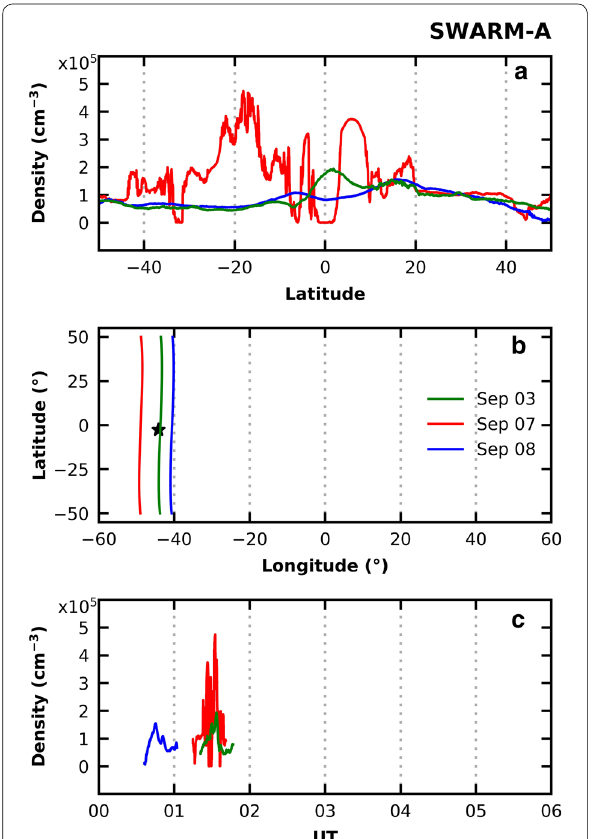
Fig. 10 SWARM-A satellite data for the days 03 (green), 07 (red) and 08